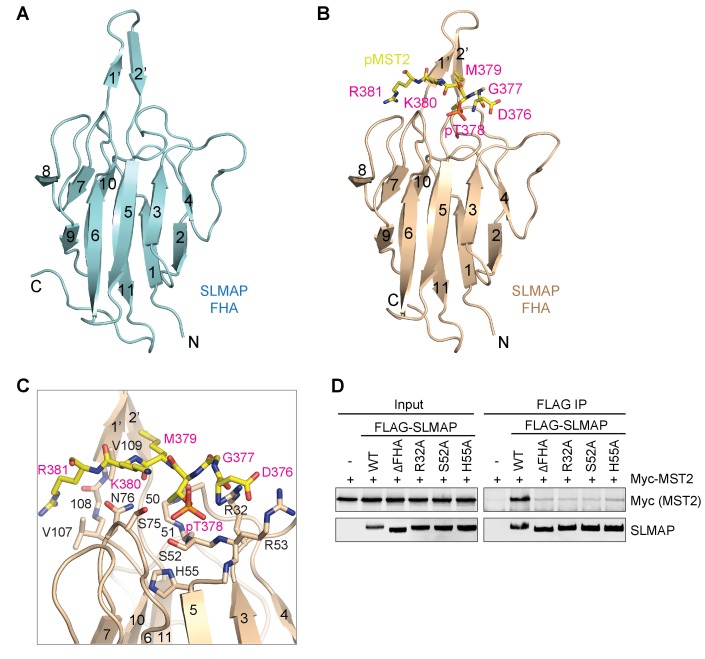
Crystal structures of SLMAP FHA and SLMAP FHA bound to pMST2.(A) Cartoon drawing of the crystal structure of human SLMAP FHA. SLMAP FHA is colored cyan. (B) Cartoon drawing of the crystal structure of human SLMAP FHA in complex with the pMST2 peptide. SLMAP FHA is colored wheat. pMST2 is colored yellow and shown as sticks. The pMST2 residues are labeled. (C) Zoomed-in view of the pT-binding site in the SLMAP FHA-pMST2 complex. The backbones and side chains of SLMAP FHA interface residues are shown as sticks and are labeled. (D) Anti-Myc and anti-SLMAP blots of lysates (input) and anti-FLAG IP of 293FT cells transfected with the indicated plasmids.